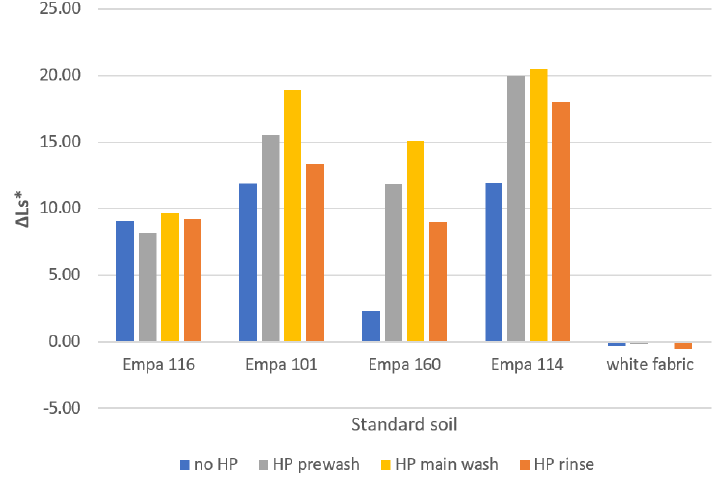
Figure 3. Lightness difference, Δ Ls * , of standard soiled fabrics washed at 40 °C with liquid detergent Ox without (no HP) and with the addition of HP in studied wash cycles.